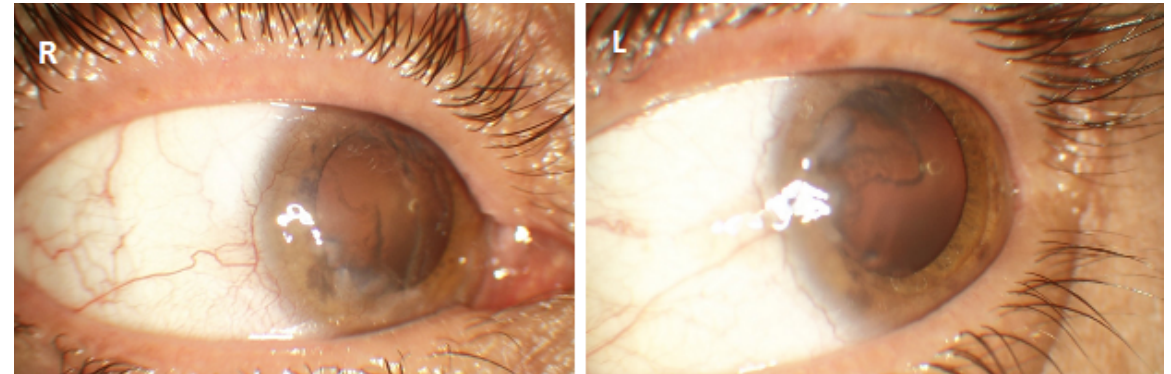
Figure 1: Corneal epithelial haze, classic “whorled” epithelium extending to the central cornea and superficial peripheral corneal neovascularization before treatment